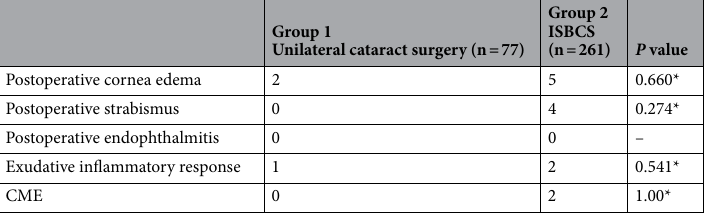
Table 6. Incidence of postoperative complications one month after surgery. CME, cystoid macular edema; ISBCS, immediate sequential bilateral cataract surgery. *Fisher’s exact